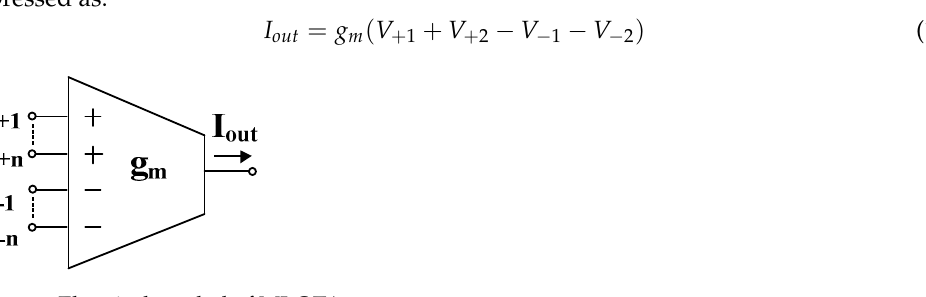
Figure 1. Electrical symbol of MI-OTA.